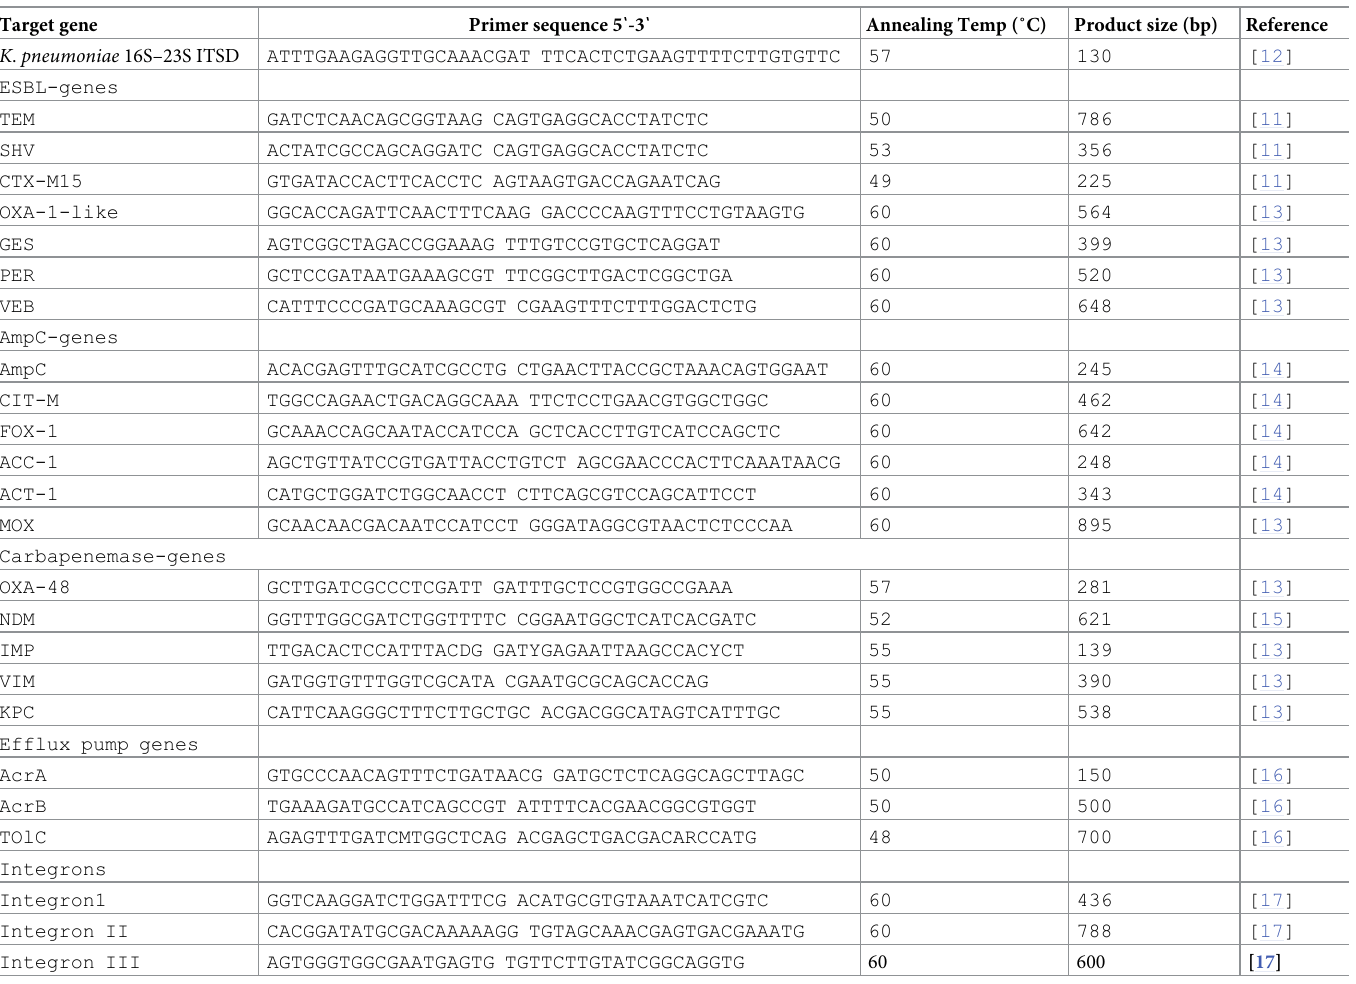
Table 1. The sequence of primers used in the PCR